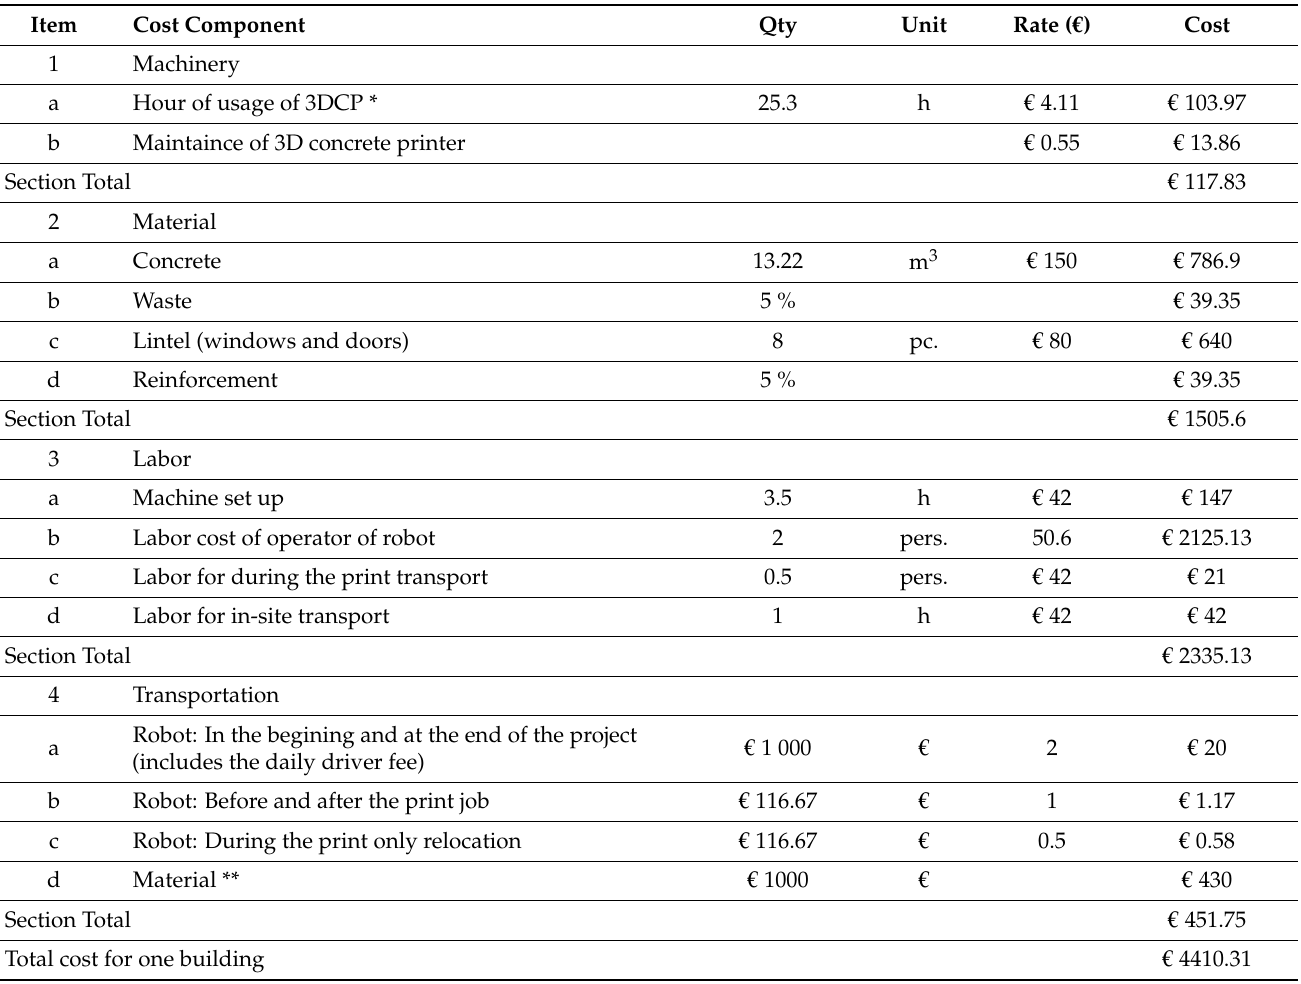
Table A5. Scenario 4 cost model in